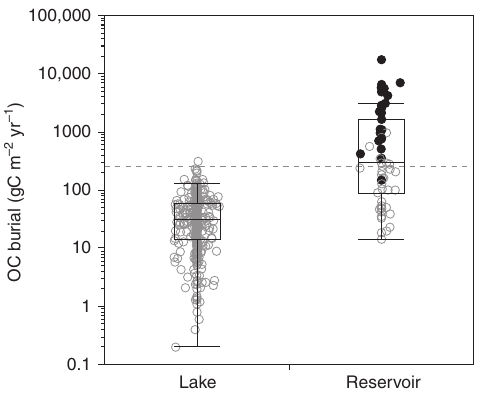
Fig. 1 Modern organic carbon burial rates from global lakes and reservoirs. Each circle corresponds to one sampled system; small agriculture ponds from ref. 27 are in black. Box plots show median (line), interquartile range (box) and 10th – 90th percentile (whiskers). The horizontal dashed line indicates global average. n = 344 for lakes and 59 for